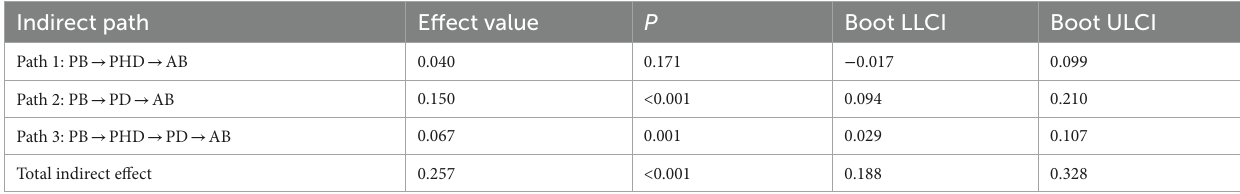
TABLE 2 Indirect effects of parental burnout on academic burnout.